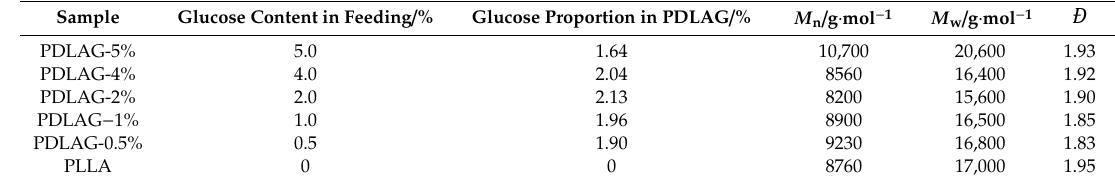
Table 1. The M n , M w , and dispersity